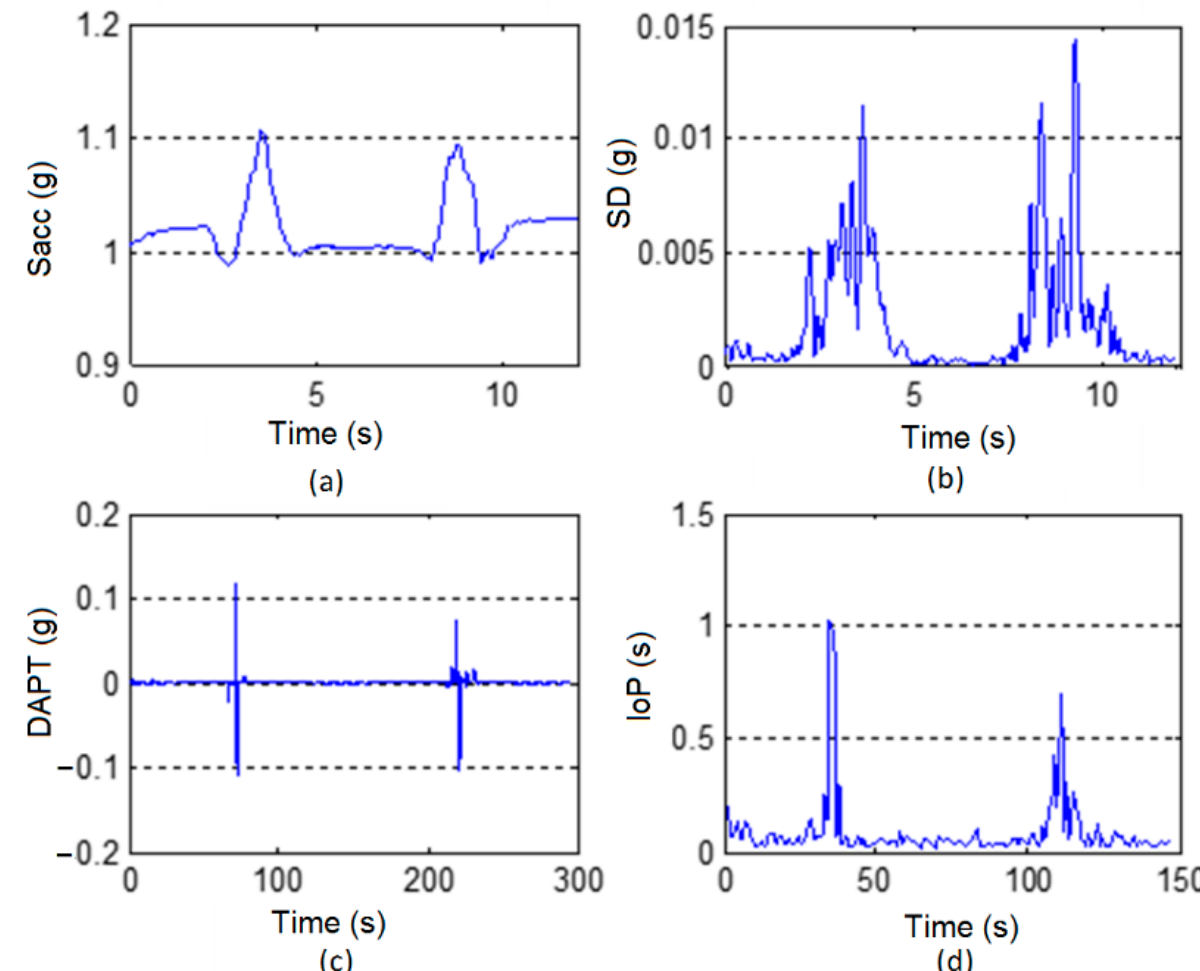
Figure 12. Diagram of features in D07: ( a ) Sacc over time; ( b ) SD over time; ( c ) DAPT over time; ( d ) IoP over time.